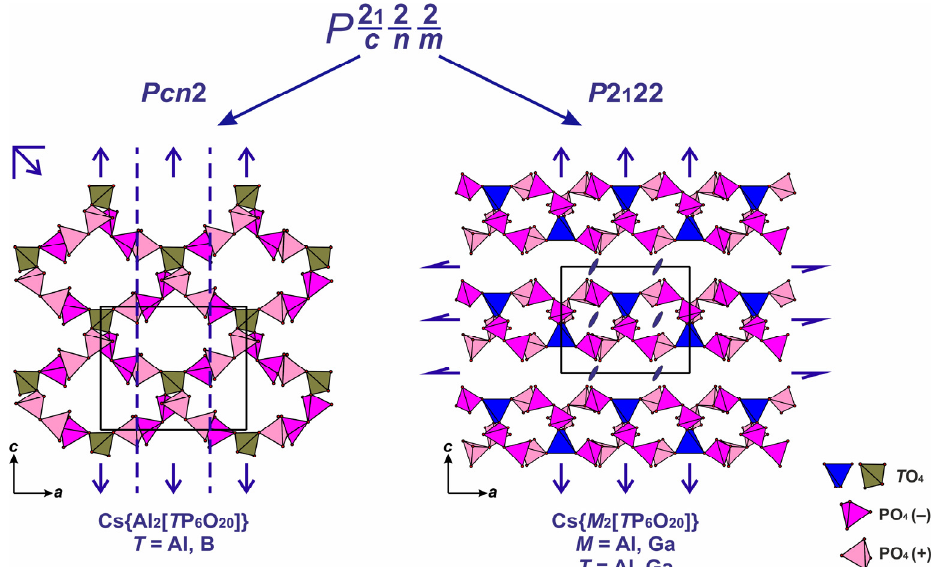
Figure 8. The symmetrical relationship between tetrahedral layers and tetrahedral pseudolayers in compounds with the general formulas Cs{Al 2 [ T P 6 O 20 ]} ( T = Al, B) and Rb{ M 2 [ T P 6 O 20 ]} ( M = Al, Ga; T = Al, Ga), respectively. The orientation of the tetrahedral pseudolayer (right) have been changed using the [001/010/100] matrix in comparison with that in the crystal structures.